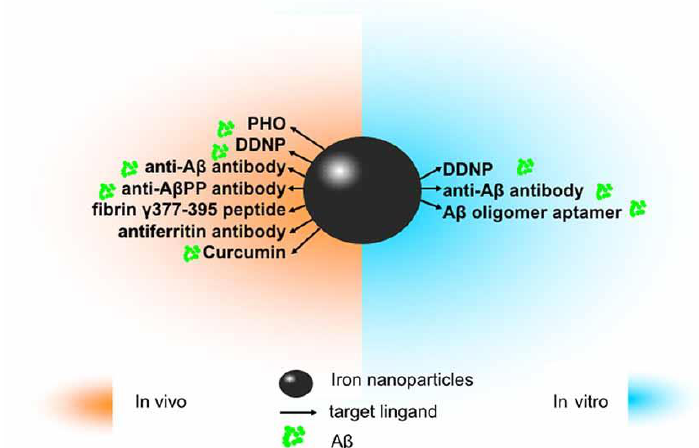
Figure 6. The application of iron oxide nanoparticles (IONPs) in diagnosis and treatment of Alzheimer’s disease (AD). Since amyloid β (Aβ) has been identified as an ideal imaging biomarker of AD at present, with the help of magnetic resonance imaging (MRI), IONPs can be used for the detection of Aβ to assist in diagnosis and treatment of AD. In vitro, magnetic nanoparticles (MNPs) labeled with antibodies against Aβ - 40 and Aβ - 42 is applicable to detect Aβ in the blood. Conjugated with the Aβ oligomer aptamer and the complementary oligonucleotide of the Aβ oligomer aptamer, IONPs can be developed as a method to measure the Aβ oligomer in the artificial cerebrospinal fluid (CSF). DDNP-superparamagnetic iron oxide nanoparticles (SPIONs) with high affinities to A β aggregates can be detected by fluorophotometry. In vivo, ultrasmall superparamagnetic iron oxide (USPIO)-PHO could mark amyloid plaques in the NMRI mice brain; anti-A β protein precursor (A β PP) antibody-conjugated SPIONs can visualize the number of plaques in A β PP / PS1 transgenic mice. DDNP–SPIONs nanoparticles significantly decrease the signal intensity (SI) in the hippocampal area in the rat AD model. Curcumin-conjugated superparamagnetic iron oxides (SPIOs) can detect amyloid plaques in Tg2576 mice brains. Fibrin γ 377–395 peptide-conjugated γ -Fe 2 O 3 nanoparticles could specifically inhibit the microglial cells in rTg4510 tau-mutant mice and thus provide a possible therapeutic strategy towards neurodegenerative tauopathies. In addition, magnetic IONPs bound to an anti-ferritin antibody were developed to detect ferritin protein in areas with a high amount of amyloid plaques in the brain of a transgenic AD mouse model. BBB, blood–brain barrier. Adapted with some modification from [72], Luo et al., 2020.